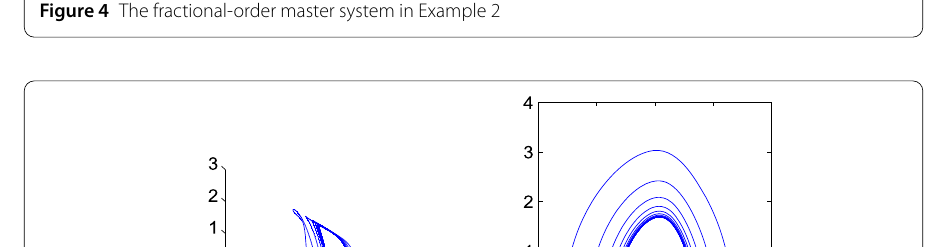
Figure 4 The fractional-order master system in Example 2